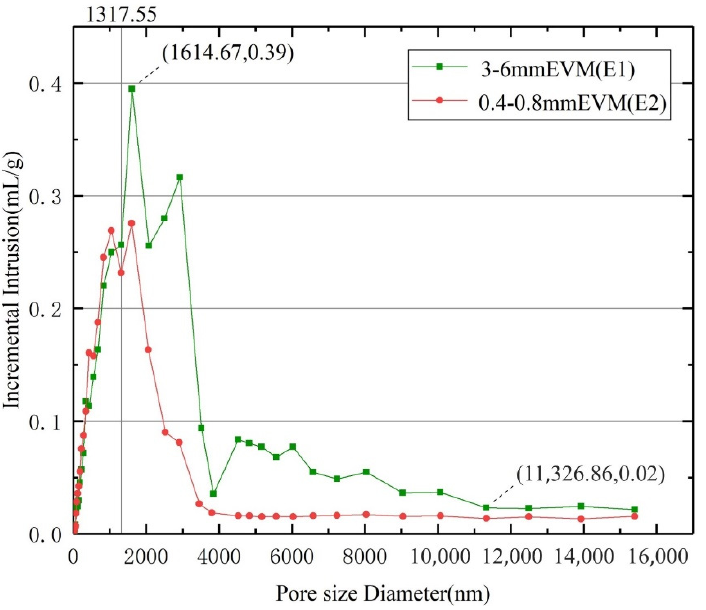
Figure 5. Incremental intrusion vs pore size.